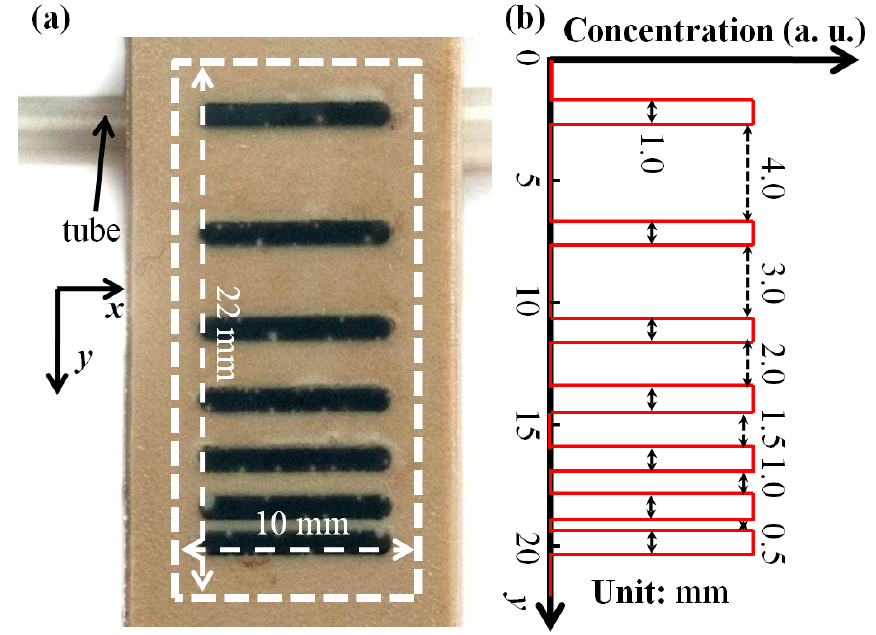
Figure 1. ( a ) Photo of the multiline phantom; ( b ) schematic of the concentration-versus- y curve.